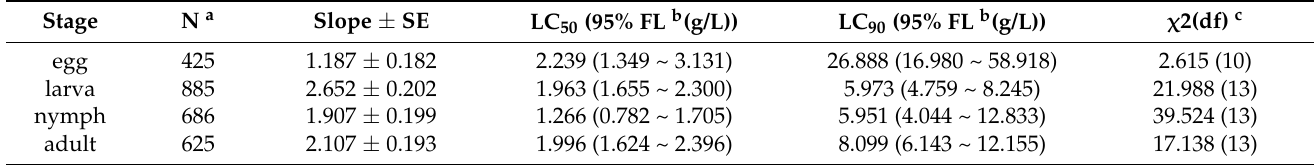
Table 1. The overall lethal effect of GC16 on Tetranychus pueraricola in the different developmen- tal